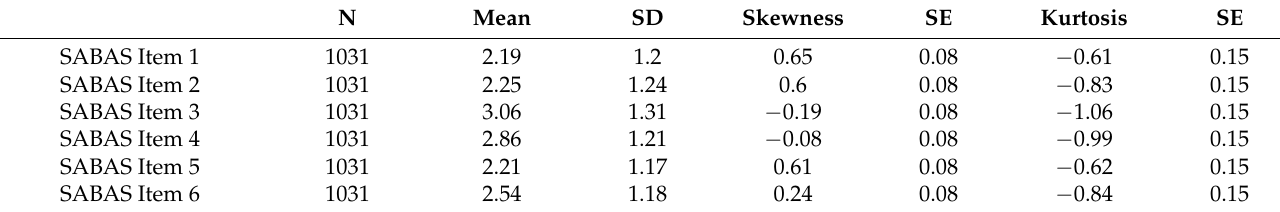
Table 2. Summary statistics for the Smartphone Application-Based Addiction Scale.